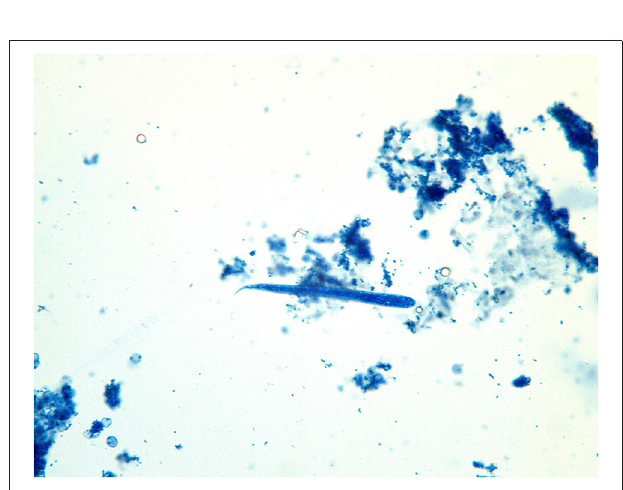
FIGURE 4 | Onchocerca lupi larva recovered from the skin-snip biopsy.